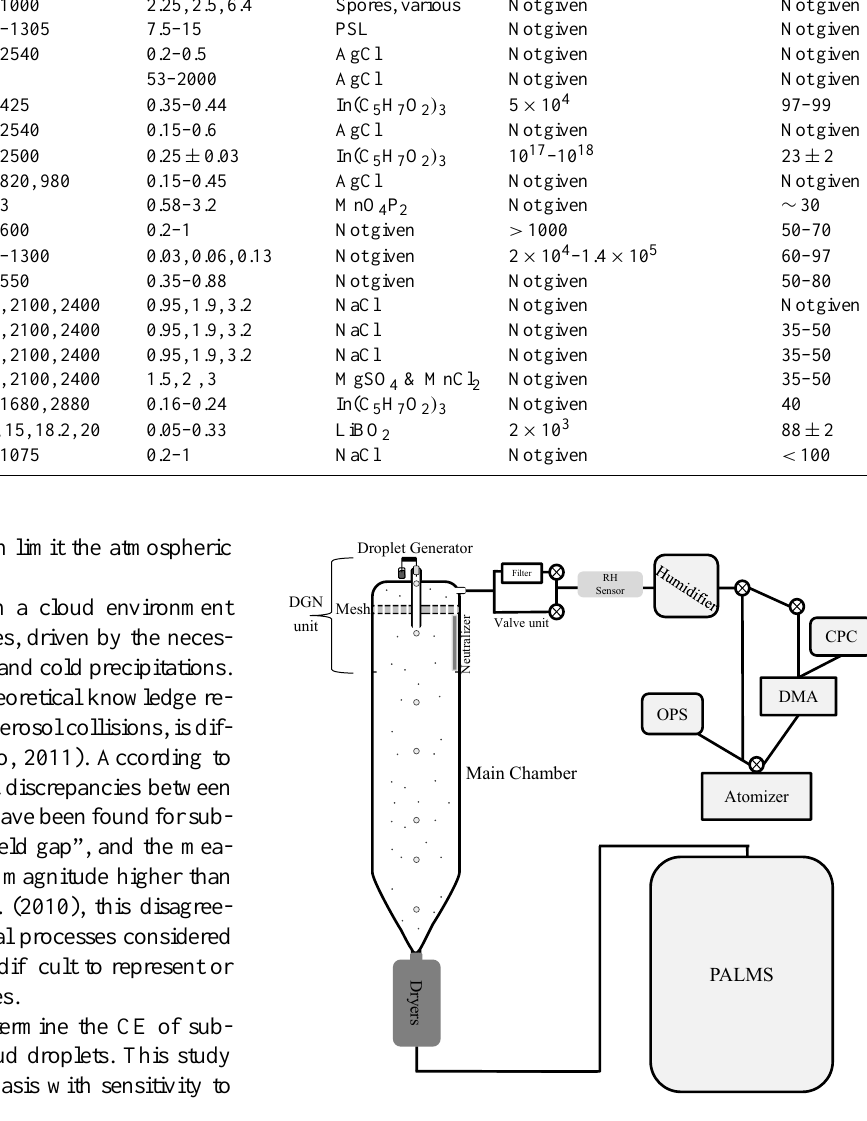
Figure 2. Experimental setup. DGN denotes the droplet generation and neutralizer unit. Additional description is provided in the